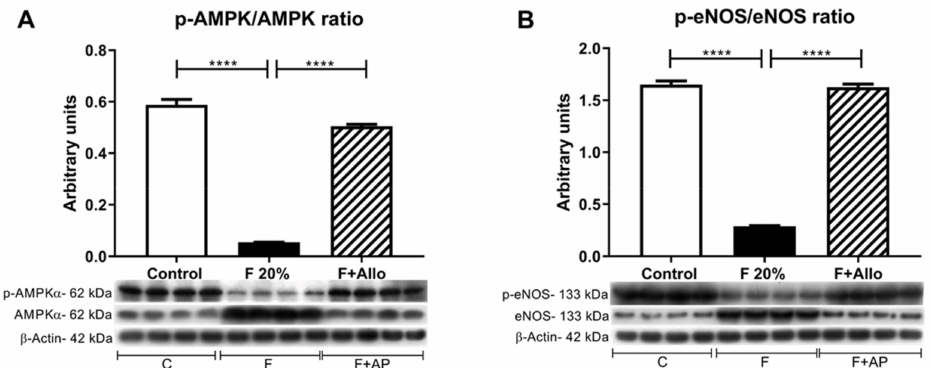
Figure 5. AMPk and eNOS activation is reduced after an acute load of fructose. In high fructose fed rats challenged with an acute load of fructose, there was a decreased activation of AMPk ( A ) and eNOS ( B ). Allopurinol treatment prevented all these e ff ects. For western blotting, 4 out 5 randomly selected samples per group were analyzed. **** = p <